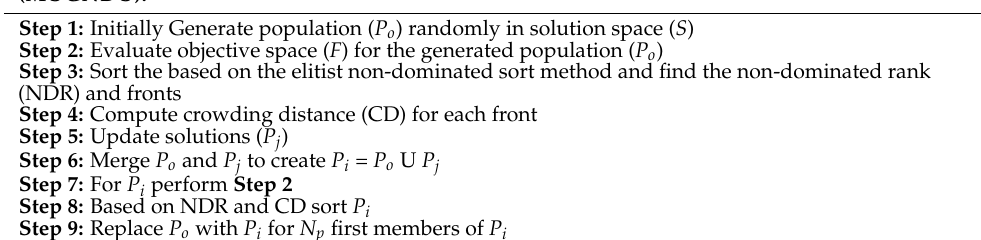
Algorithm 1: Pseudocode of Multi-objective Generalized Normal Distribution Optimization